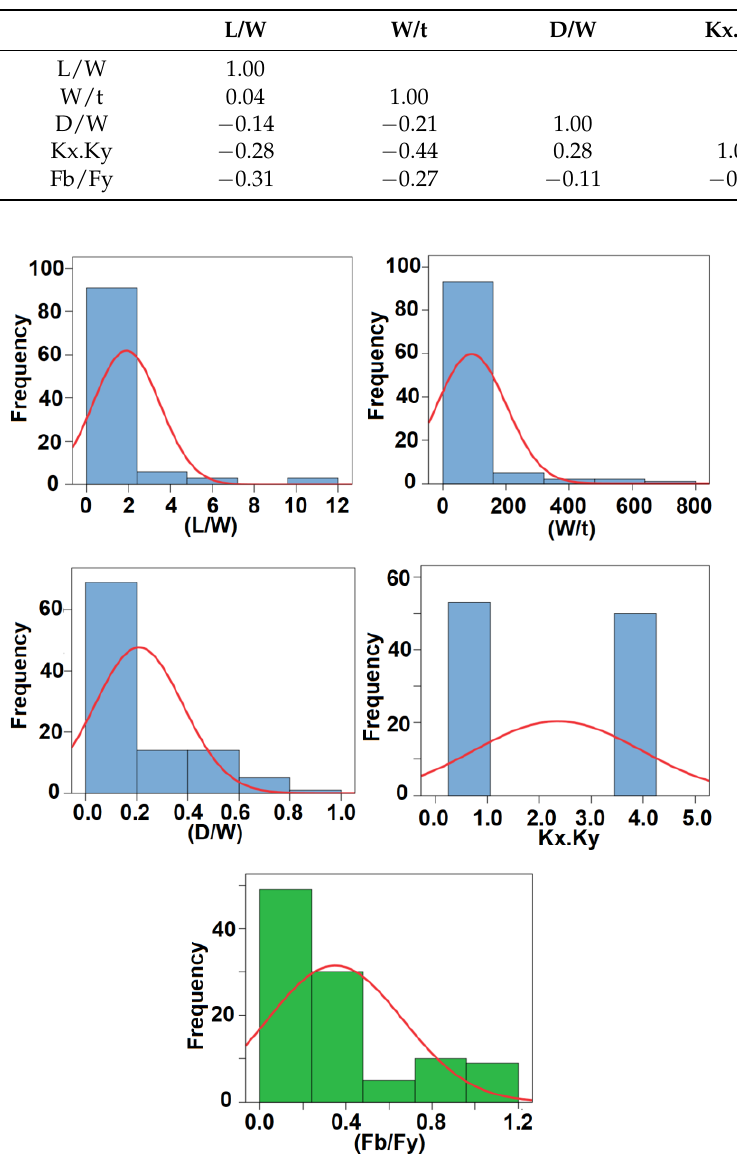
Figure 3. Distribution histograms for inputs (in blue) and outputs (in green). Table 2. Pearson correlation matrix.